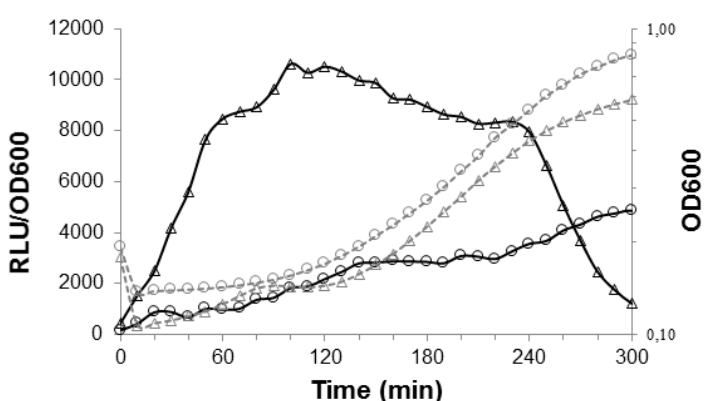
Figure 1. Growth and luciferase activity levels for the S. thermophilus TIL1557 strain (P pptAB - luxAB ) grown in chemically defined medium (CDM) ( Δ ) versus M17lac ( ). The growth curves (OD 600 ) are depicted using gray dotted lines, and the relative levels of luciferase activity (RLU/OD 600 ) are depicted using black solid lines. Data shown are representative of three independent experiments.